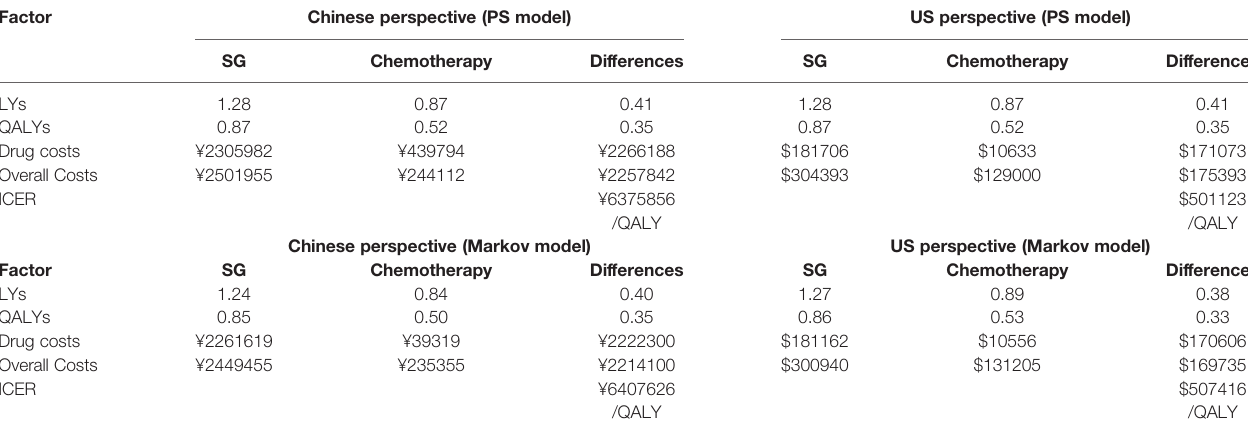
TABLE 2 | Base case results with PS model and Markov model from the Chinese and US perspectives.